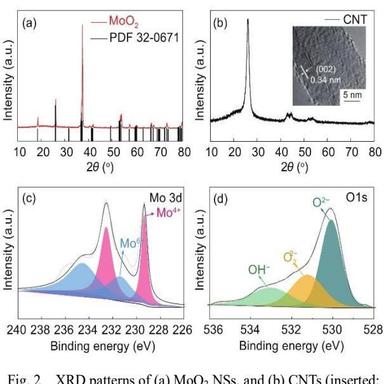
RD patterns of (a) MoO2 NSs, and (b) CNTs (inserted: HRTEM image of CNTs), high resolution XPS spectra of (c) Mo 3d and (d) O 1s of MoO2 NSs.